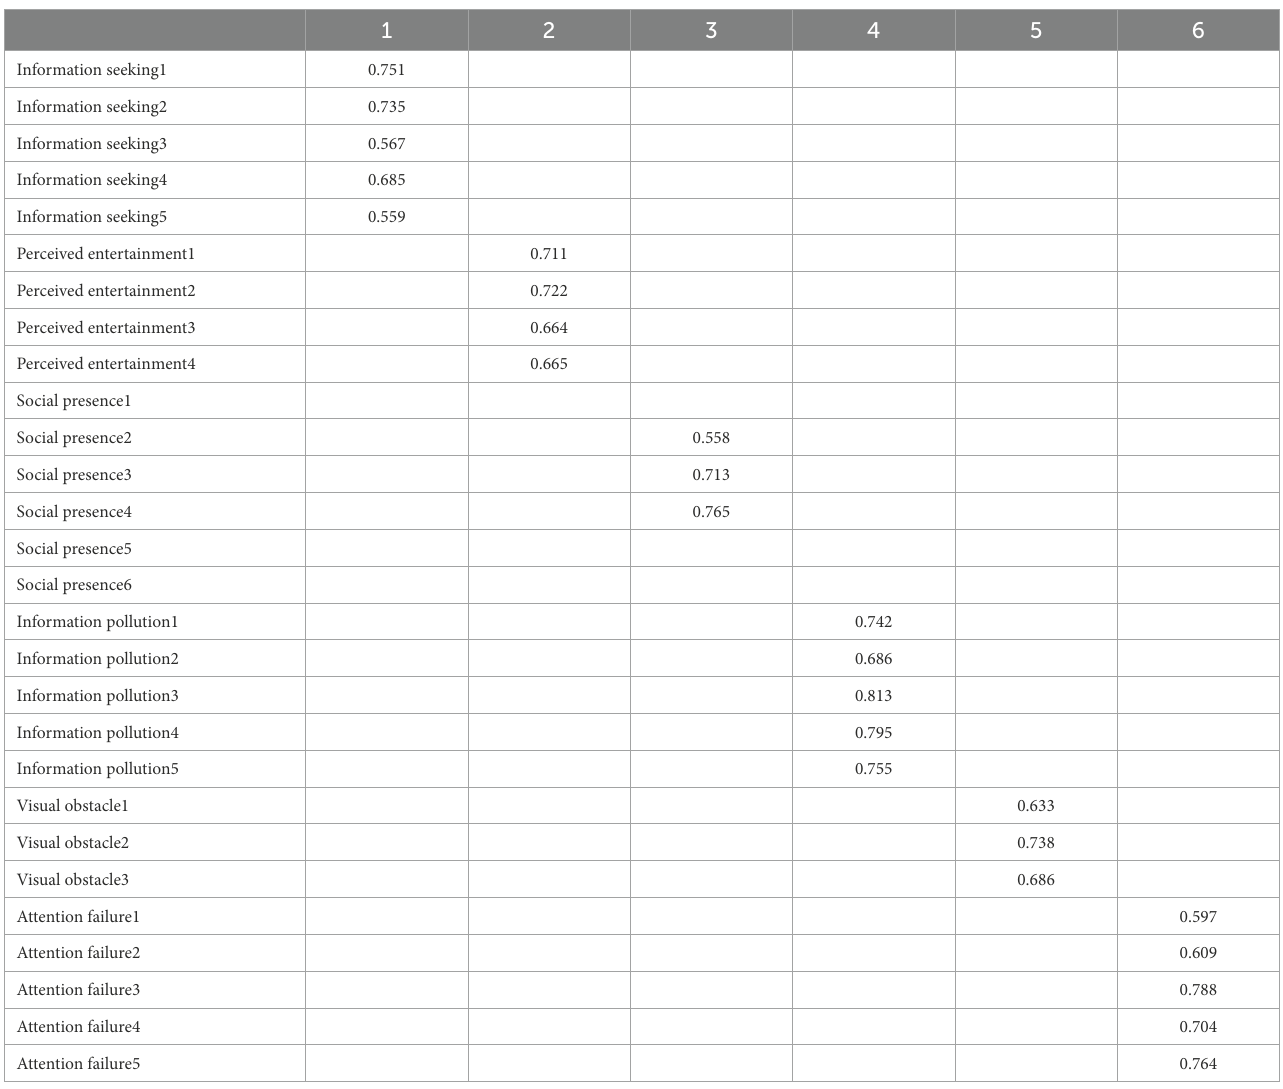
TABLE 6 Rotated component matrix.